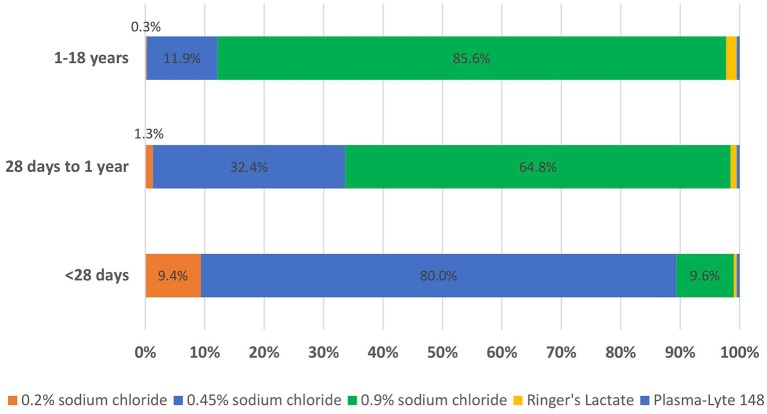
Primary maintenance intravenous fluid, by age.